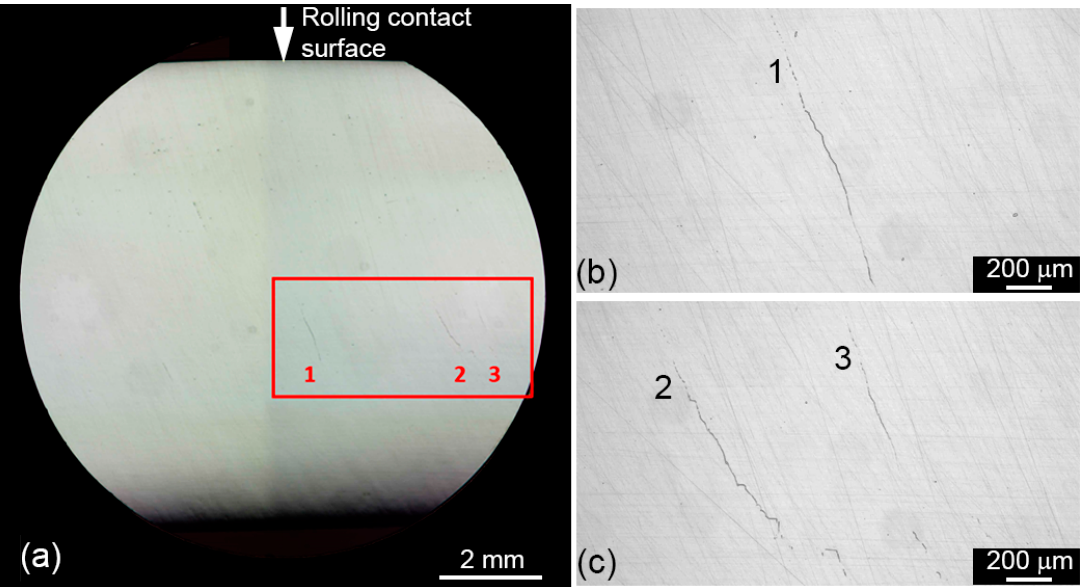
Figure 10. ( a ) Subsurface cracks revealed in metallographic sections of the test roller and ( b , c ) magnified views of three subsurface roller-fatigue induced cracks marked 1–3.